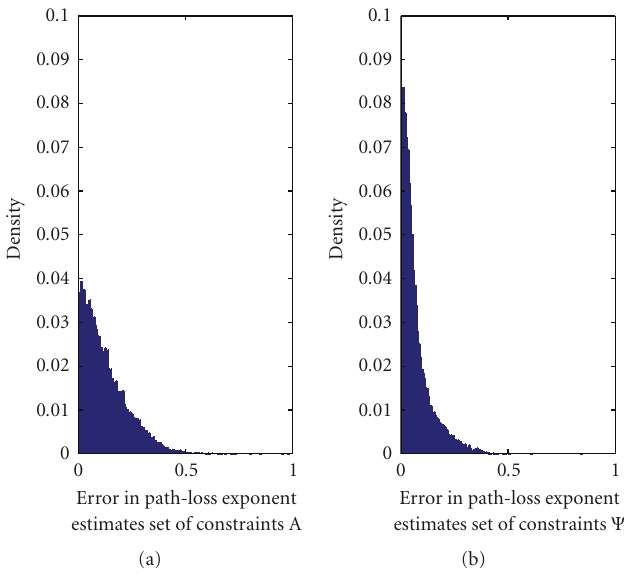
Figure 4: Histogram of errors in the path-loss exponent estimation for the di ff erent sets of constraints Λ and Ψ .